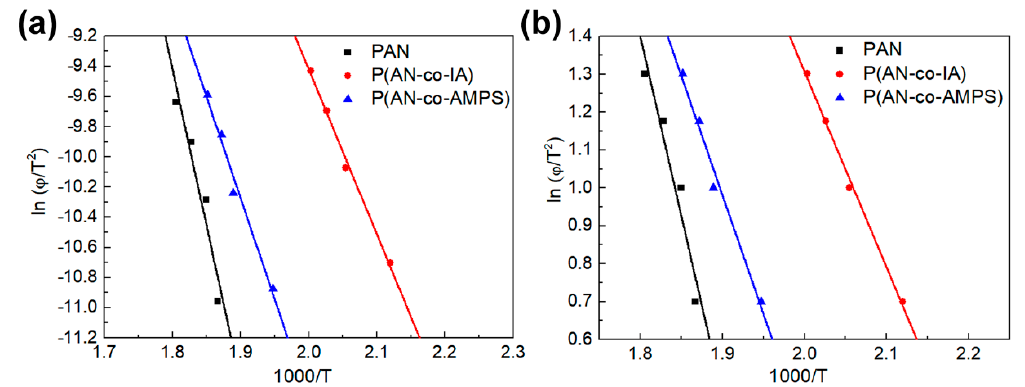
Figure 5. ( a ) Kissinger method and ( b ) Ozawa method for PAN, P(AN-co-IA), and P(AN-co-AMPS) nanofibers (plotting with Peak1).